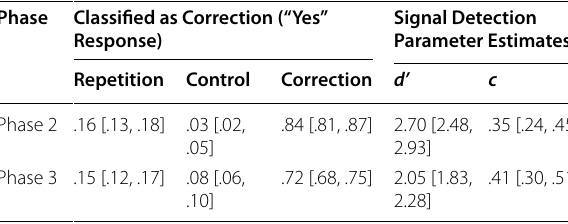
Table 1 Probabilities of correction classification and signal detection parameter estimates: Experiment 1 Phase Classified as Correction (“Yes” Response)